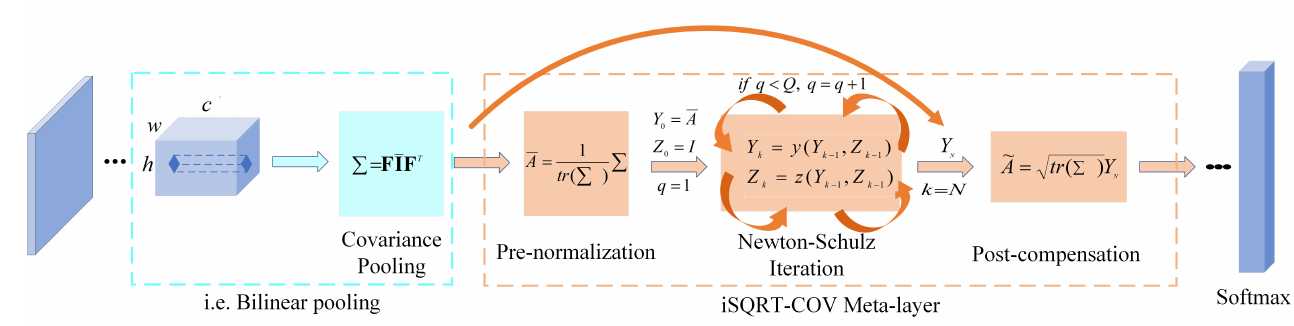
Figure 3. iSQRT-COV